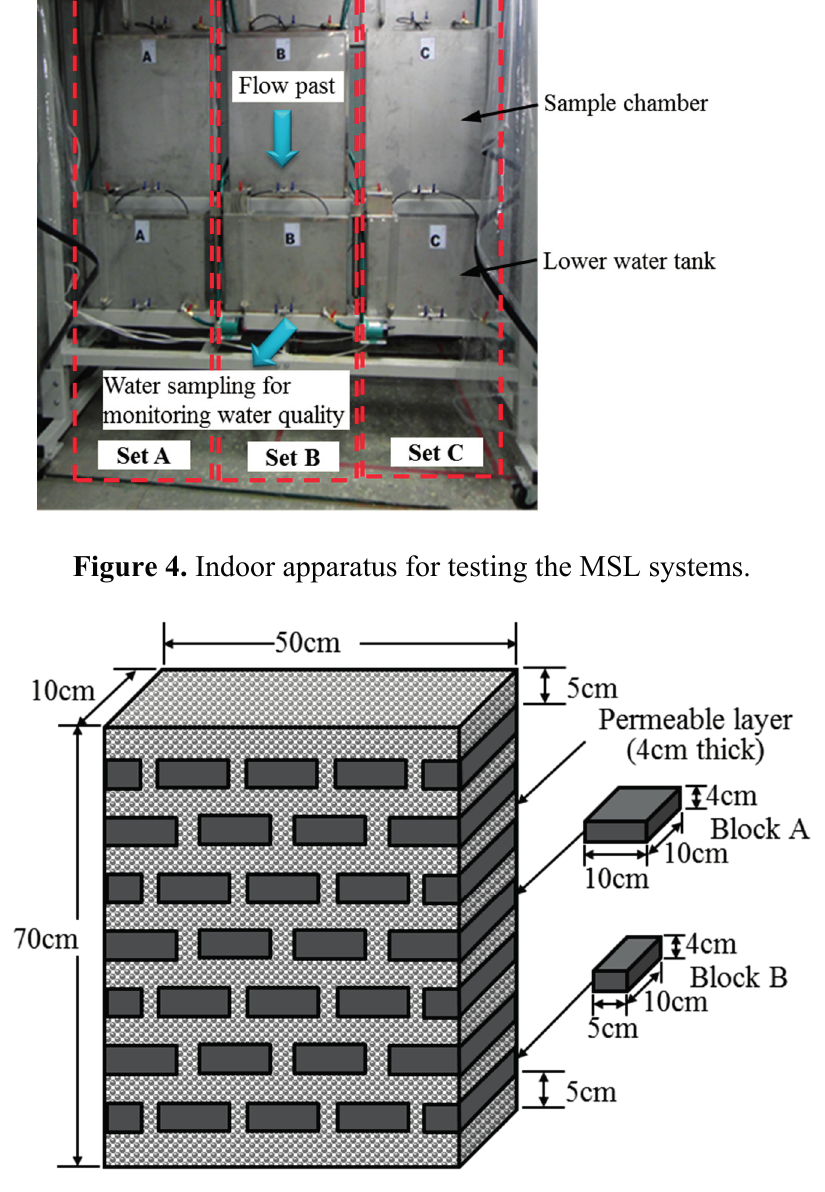
Figure 5. Material allocation within the sample